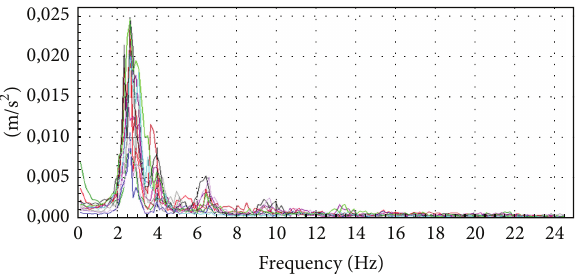
Figure 31: Frequency spectrum, ambient vibration.